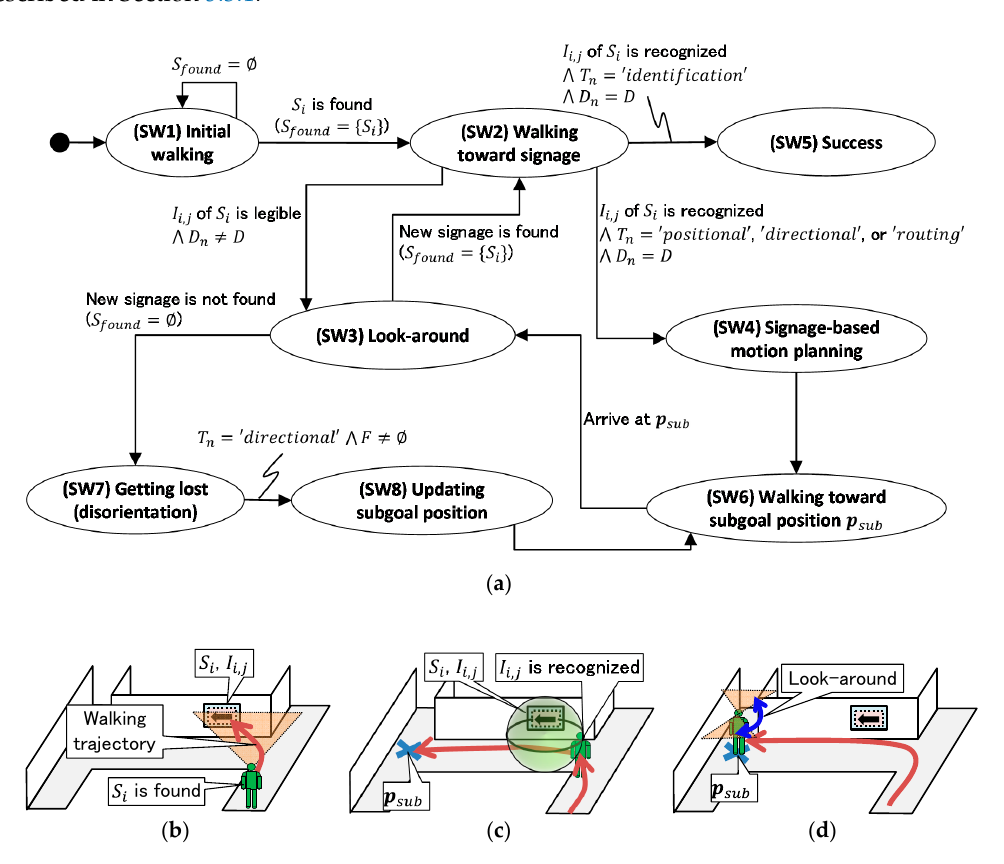
Figure 7. Wayfinding decision-making based on signage perception: ( a ) Wayfinding state transition; ( b ) walking toward signage; ( c ) walking toward subgoal position; ( d ) look-around.